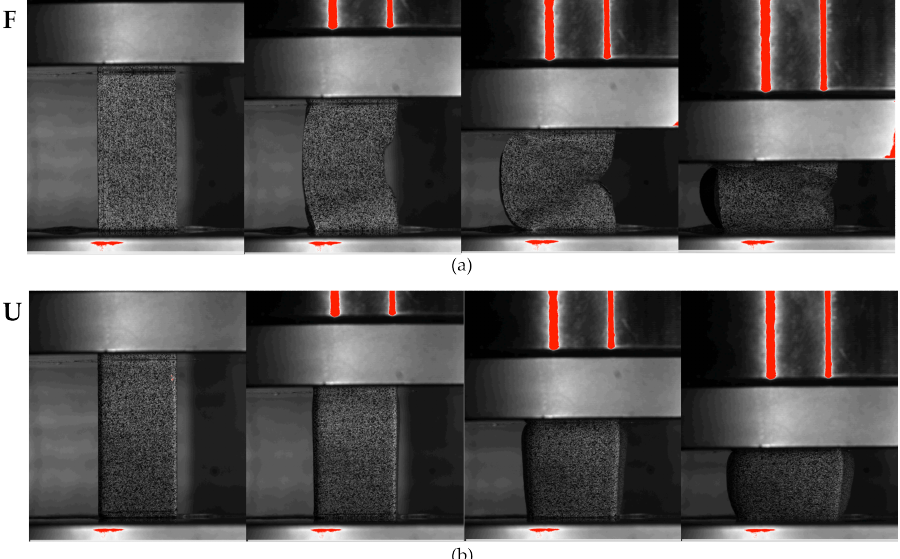
Figure 9. Compression behaviour of Onyx specimens showing ( a ) buckling behaviour of flat speci- mens; and ( b ) bulging behaviour of upright